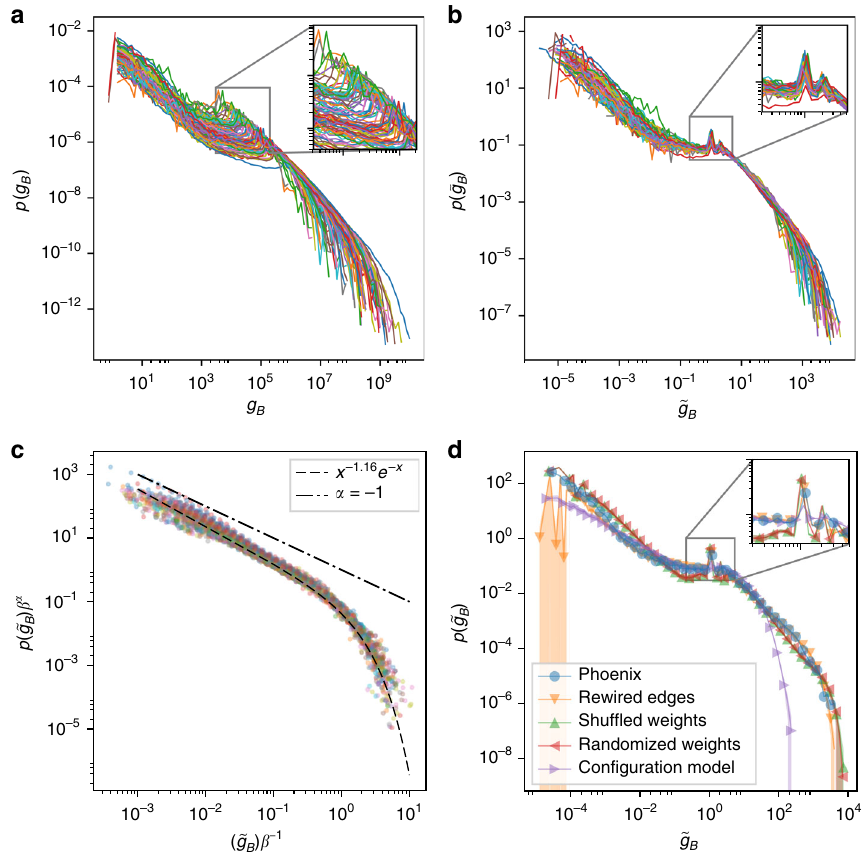
Fig. 2 Betweenness invariance in urban streets. a The betweenness pdf for all 97 cities at full-resolution. The peak of the distribution for each city is shown as inset. b The version of the distribution after rescaling by the number of nodes N showing the alignment of the peaks across all cities (also shown as inset). c The collapse of the tails after rescaling with respect to β . The dashed line shows the analytically computed asymptotic scaling for a Cayley-tree (Eq. (3)). d The BC distribution of various random graph models described in the text compared to the baseline distribution of Phoenix as a representative example. Shaded area re fl ects fl uctuations around the average over hundred realizations of each model. Apart from the (non-spatial) con fi guration model, we see minimal changes in the location of the peak(s) (zoomed in inset) or shape of the tail. (Details including 2 sample KS statistics in Supplementary Figs. 6 and